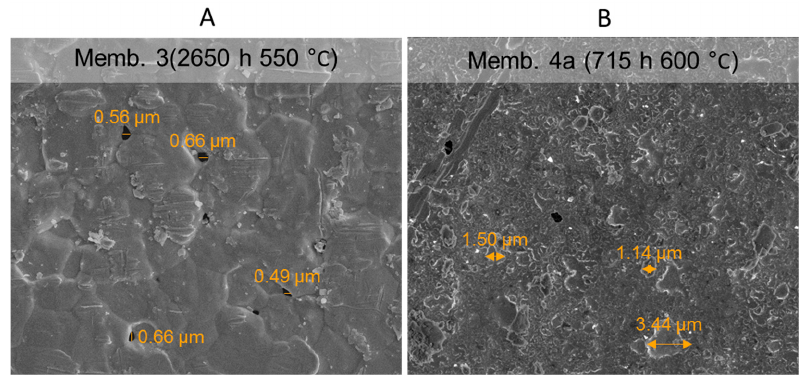
Figure 14. SEM picture of pinholes on the surface of membrane 3 after 2650 h and up to 550 °C (A), SEM picture of the surface of membrane 4b after 715 h of operation up to 600 °C (B).